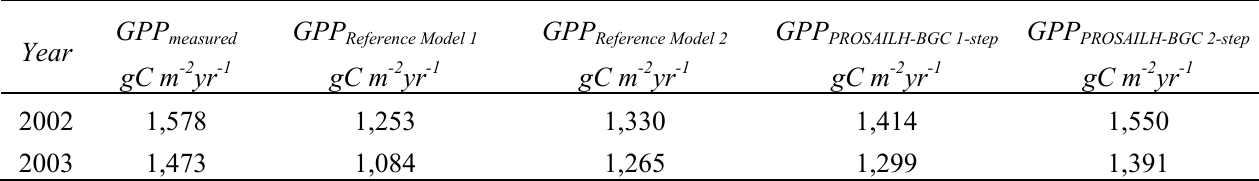
Table 4. Annual GPP measured and simulated by BIOME-BGC with parameterization from literature and internal phenology (Reference Model 1), BIOME-BGC with parameterization from literature and observed phenology (Reference Model 2), by PROSAILH-BGC after first-step optimization with the internal phenology ( GPP